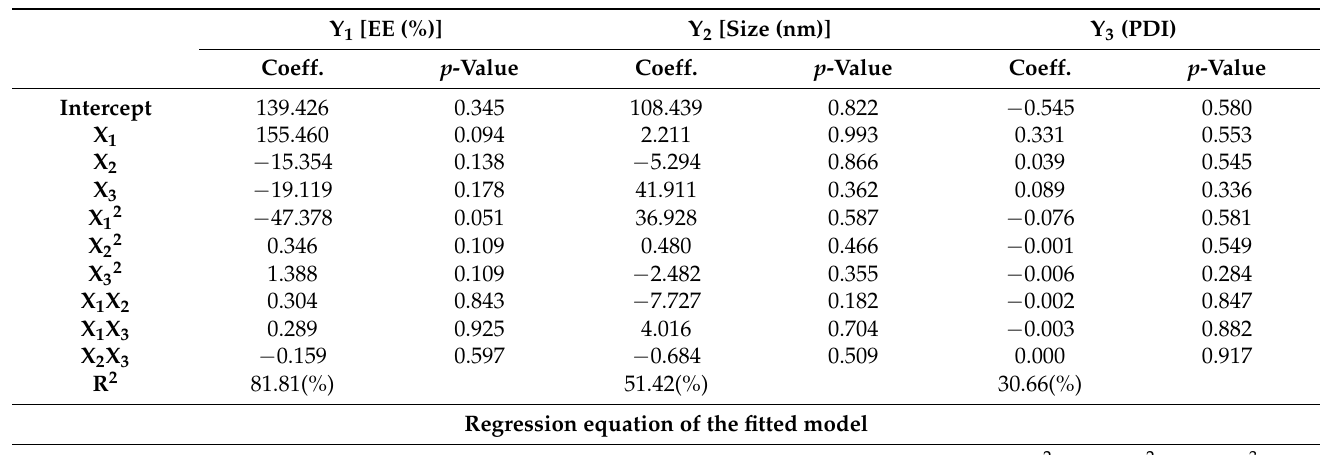
Table 3. Regression analysis for the encapsulation efficiency (Y 1 ), particle size (Y 2 ) and polydis- persity index (Y 3 ) using an interaction model based on the effect of the DOPE:CHEMS ratio (X 1 ), docetaxel:lipids ratio (X 2 ) and sonication time (X 3